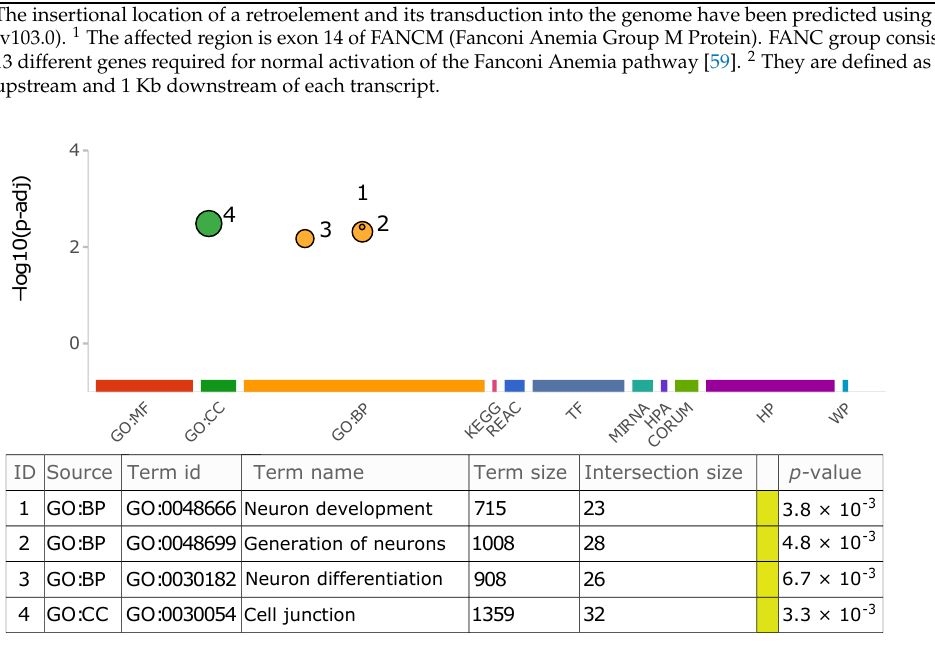
Figure 8. Overrepresented GO terms in the list of affected genes by transduction variants. The graph summarizes the explored repositories for functional enrichment analysis. The color-coded circles depict the significant biological features shared among those genes in which transductions have resided. The size of each circle reflects its term size. Moreover, each data point on the graph is listed in detail in the table. The followings are the plot abbreviations and definition of terms used in the